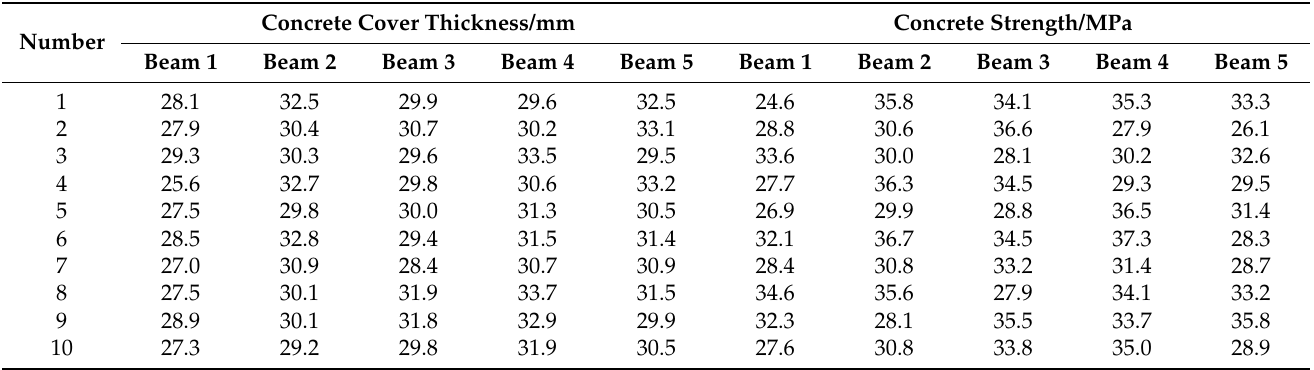
Table 1. Detection data of concrete strength and concrete cover thickness of simply supported T-beam bridge.